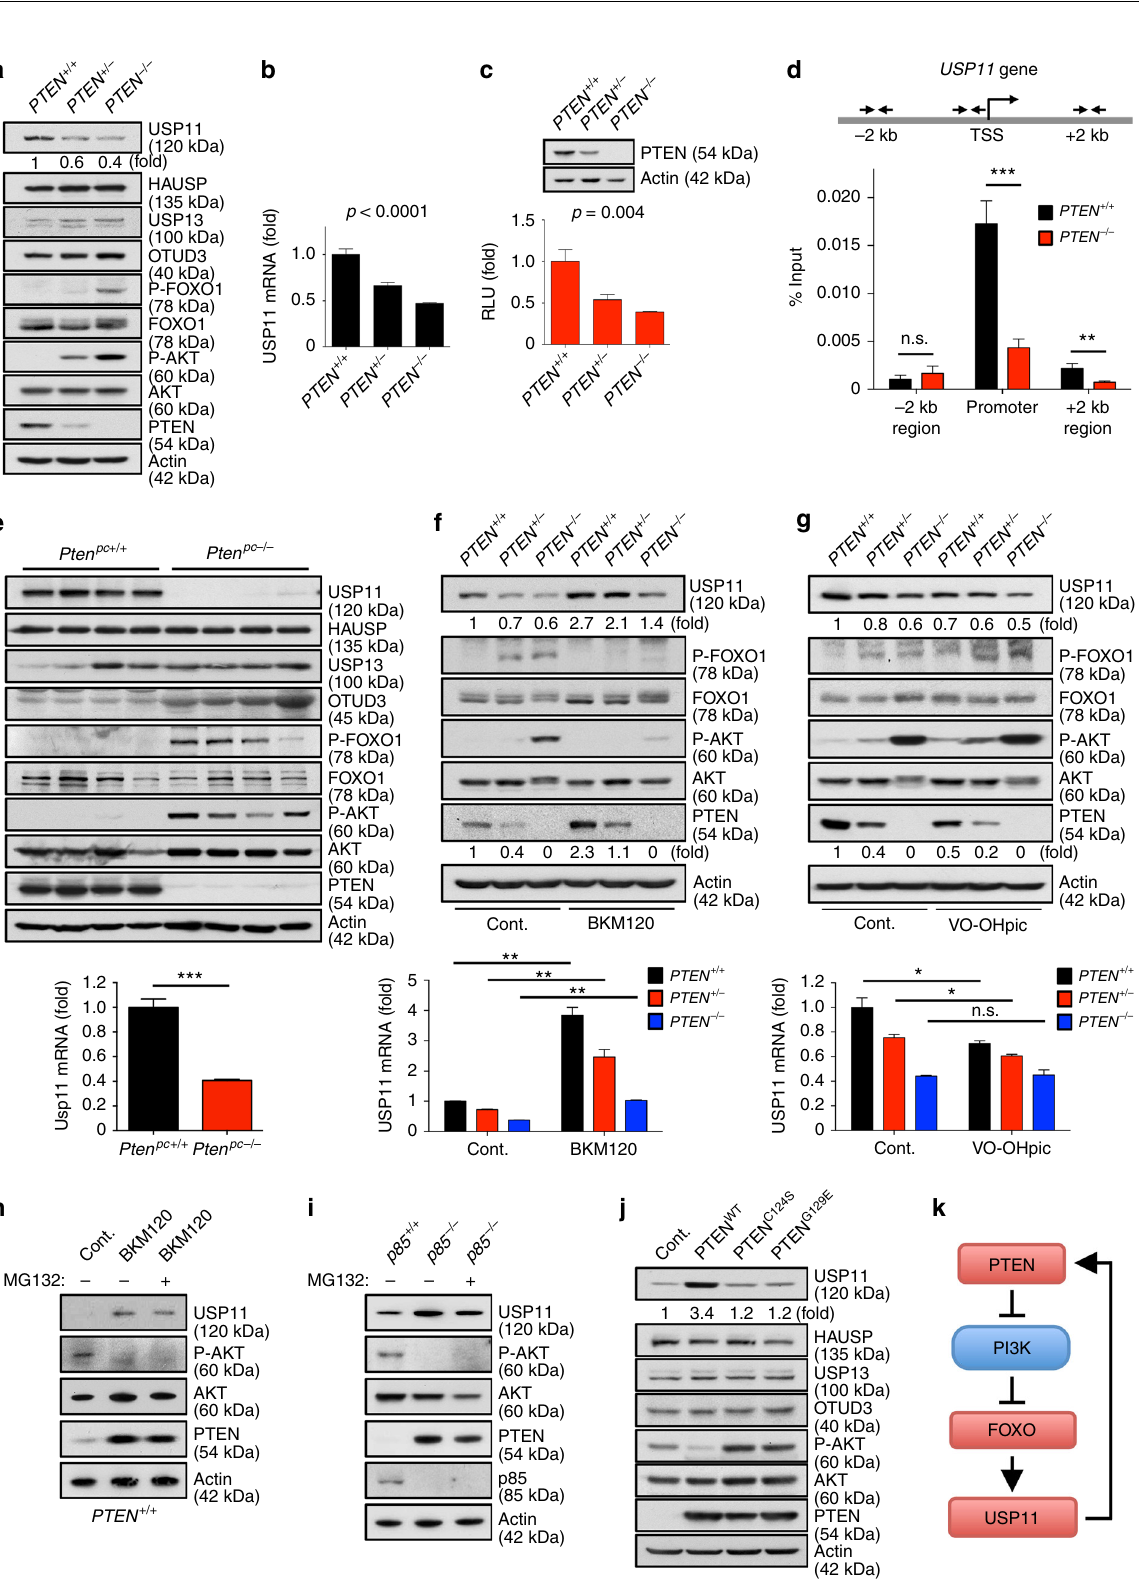
Cancer biostatistical analysis . Relative expression levels of USP11 in prostate or breast cancer patients compared to normal samples were analyzed using previously published microarray database (Stephenson ’ s prostate carcinoma (ref. 44 , n = 97); Taylor ’ s prostate carcinoma (GEO: GSE21032, n = 179); Liu ’ s breast carcinoma (GEO: GSE22820, n = 176)). For correlation analysis between USP11 and prognosis, Kaplan – Meier plotting and log-rank test were performed using a publicly accessible online tool KM Plotter (http://kmplot.com) 31 . Patients were divided into two classes